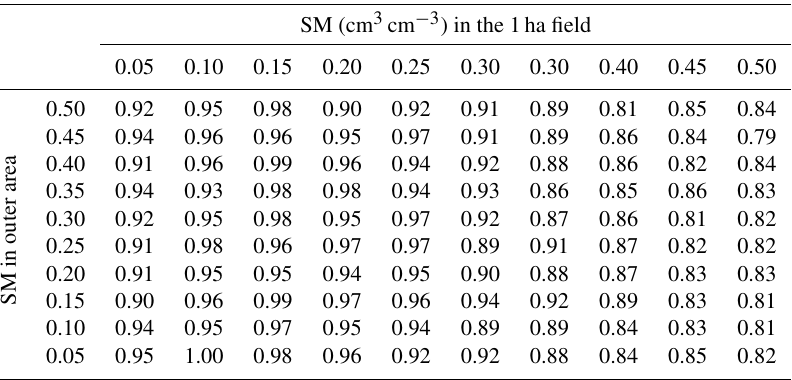
Table B1. Thermal neutrons detected with a 5mm HDPE moderator that originate within a 1ha field expressed as a fraction of the maximum